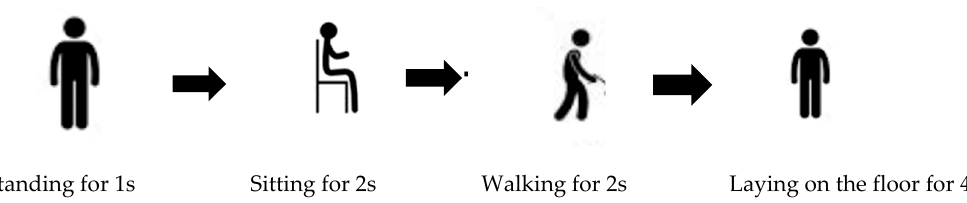
Figure 9. Different concurrent activity positions over a stipulated time. Figure 9. Di ff erent concurrent activity positions over a stipulated time.